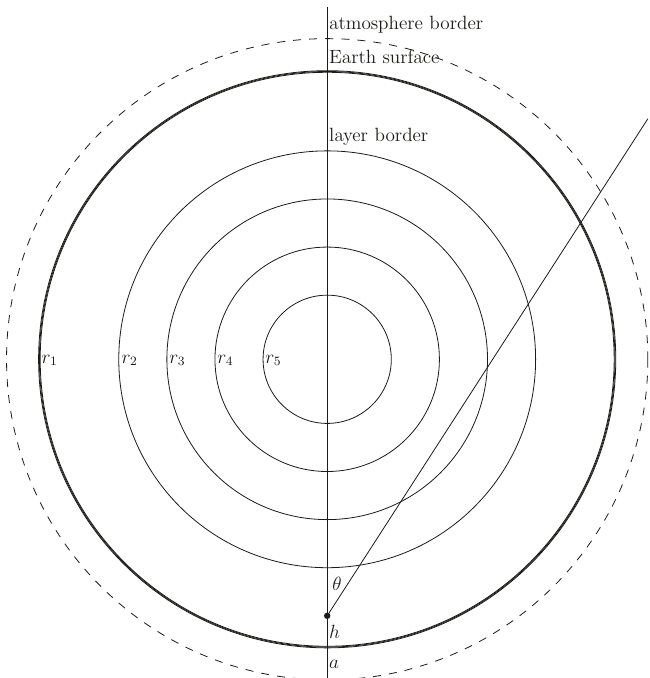
Figure 1 . Schematic picture of the Earth structure (not to scale) and de(cid:12)nition of the azimuthal angle (cid:18) . The detector, marked by black blob, is located at depth h below the Earth surface, the average atmosphere width is denoted by a